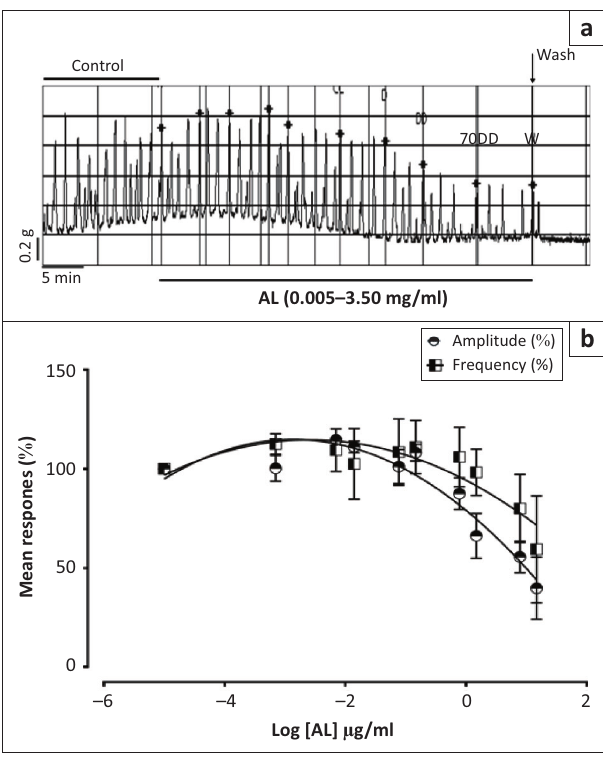
FIGURE 2: Effect of Alchornea laxiflora (AL) on spontaneous uterine contractions. Figure a represents original recordings of the activity of AL on spontaneous uterine contractions. Figure b represents concentration–response curves for the amplitude and frequency of spontaneous contractions in the presence of AL. Alchornea laxiflora displayed a somewhat biphasic effect on spontaneous contractions, with the lower concentrations showing mild stimulation and higher concentrations showing marked depression of amplitude and frequency. n = 4